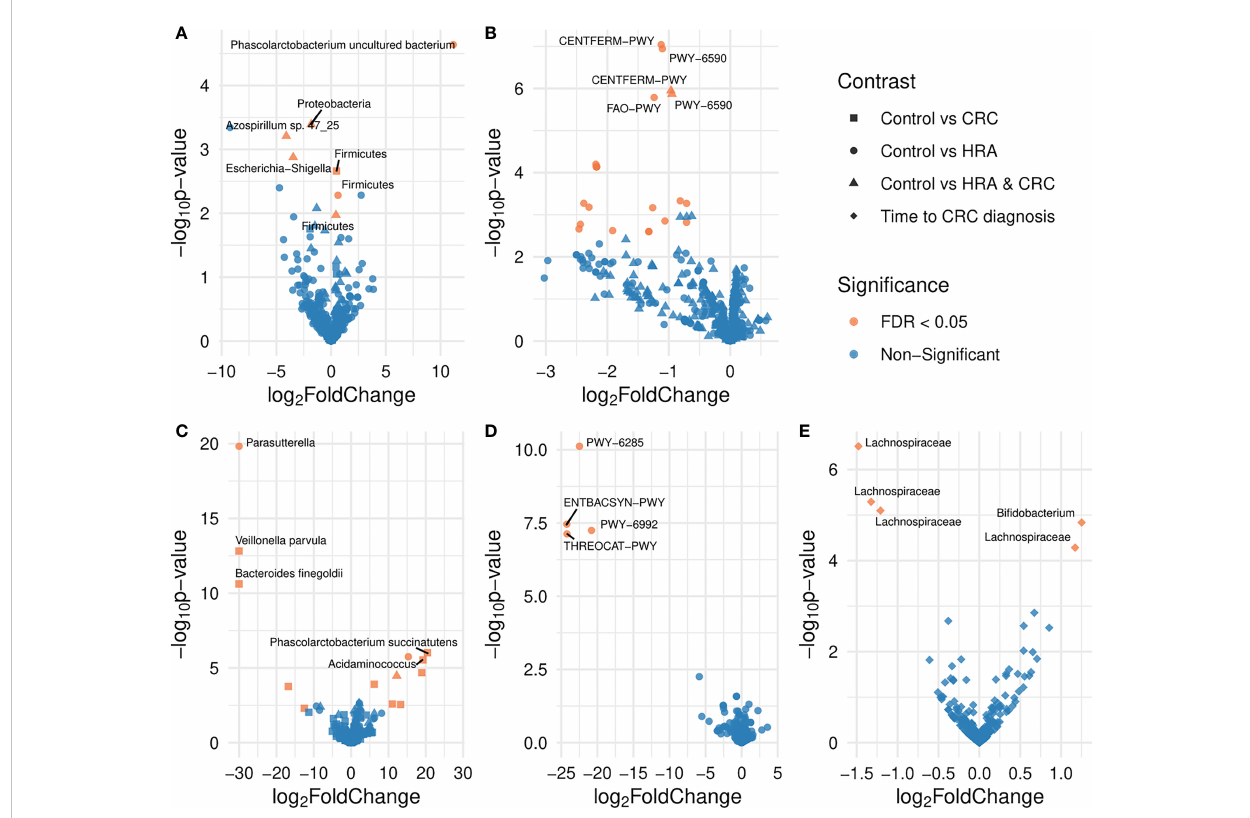
FIGURE 5 Volcano plots showing differences in the abundance of taxa and pathways between groups. FDR-signi fi cant differentially abundant taxa or pathways are highlighted in red. Group comparisons are indicated by different shapes where the control group or a shorter time to diagnosis is considered the reference. Differential abundance was analyzed for (A) amplicon sequence variants from 16S sequencing data, (B) MetaCyc pathways derived from 16S sequencing data, (C) species abundance based on metagenome shotgun sequencing, (D) MetaCyc pathways based on metagenome shotgun sequencing, and (E) amplicon sequence variants from 16S sequencing data for the 28 participants who received a CRC